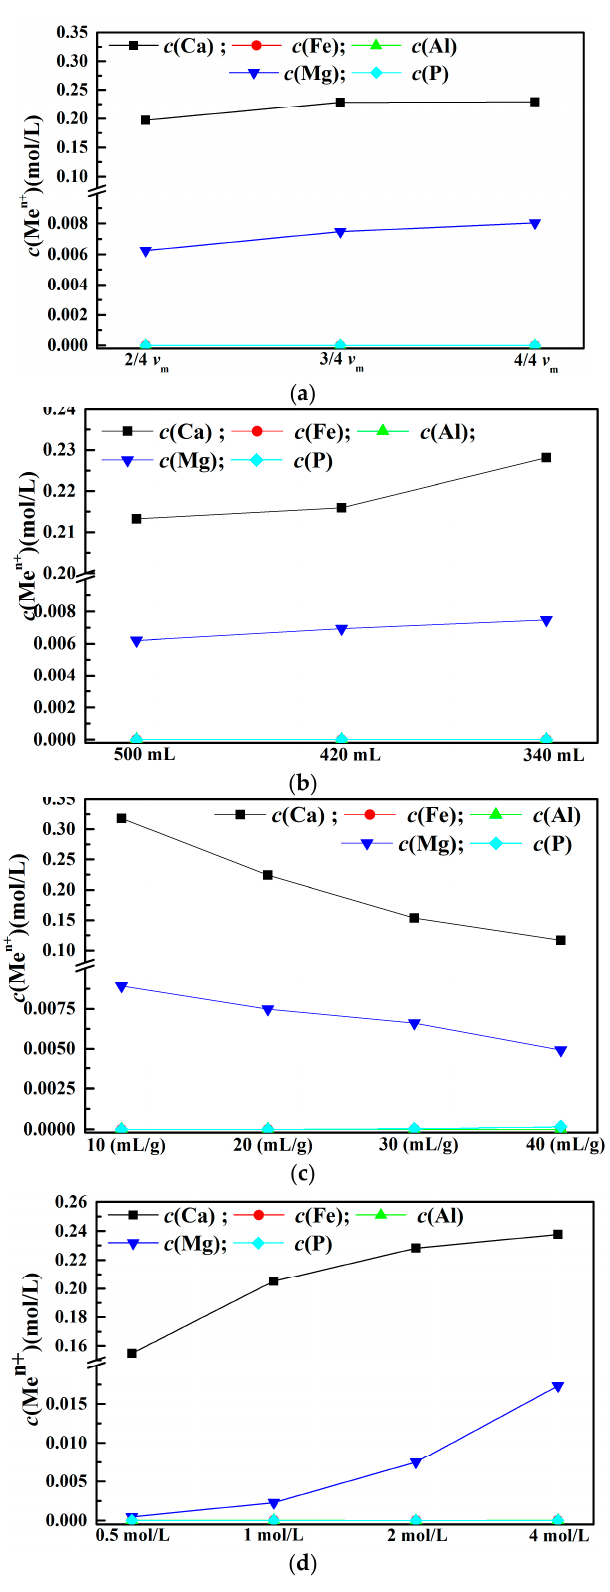
Figure 7. Effect of different experimental parameters on Me n+ leaching: ( a ) the stirring speeds; ( b ) the volume of leaching solution; ( c ) the liquid–solid ratio; ( d ) the leaching solution concentration.